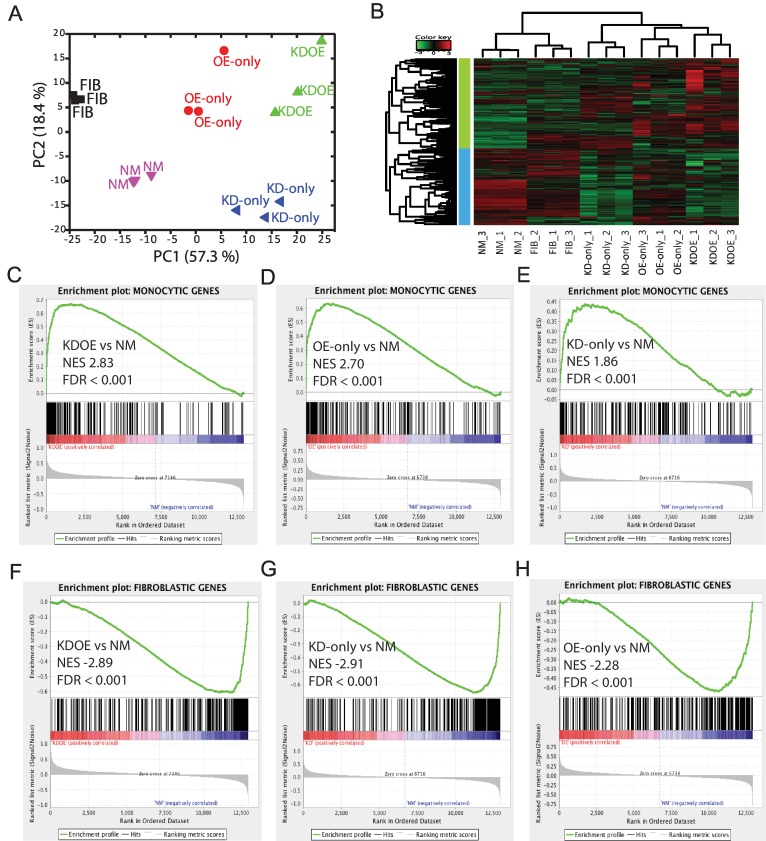
Microarray analysis of monocytic and fibroblastic gene expression in treated cells.(A) Principal component analysis of monocyte- and fibroblast-specific gene expression. (B) Heatmap diagram of monocyte- and fibroblast-specific gene expression. (C–E) The enrichment plot in the monocytic gene set of KDOE, OE-only, and KD-only. (F–H) Gene set enrichment analysis in the fibroblastic gene set of KDOE, KD-only, and OE-only.